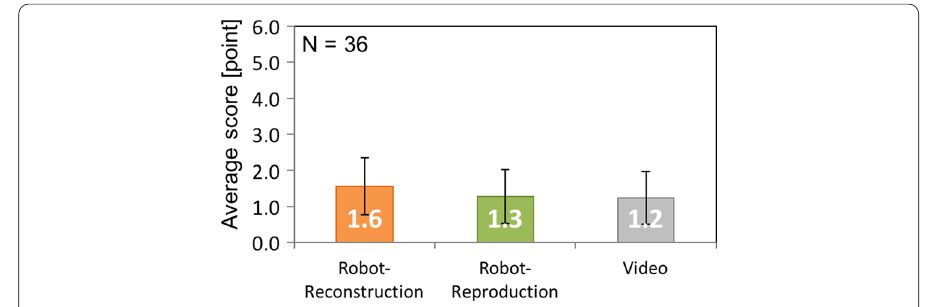
Fig. 12 Average scores of between-slides question